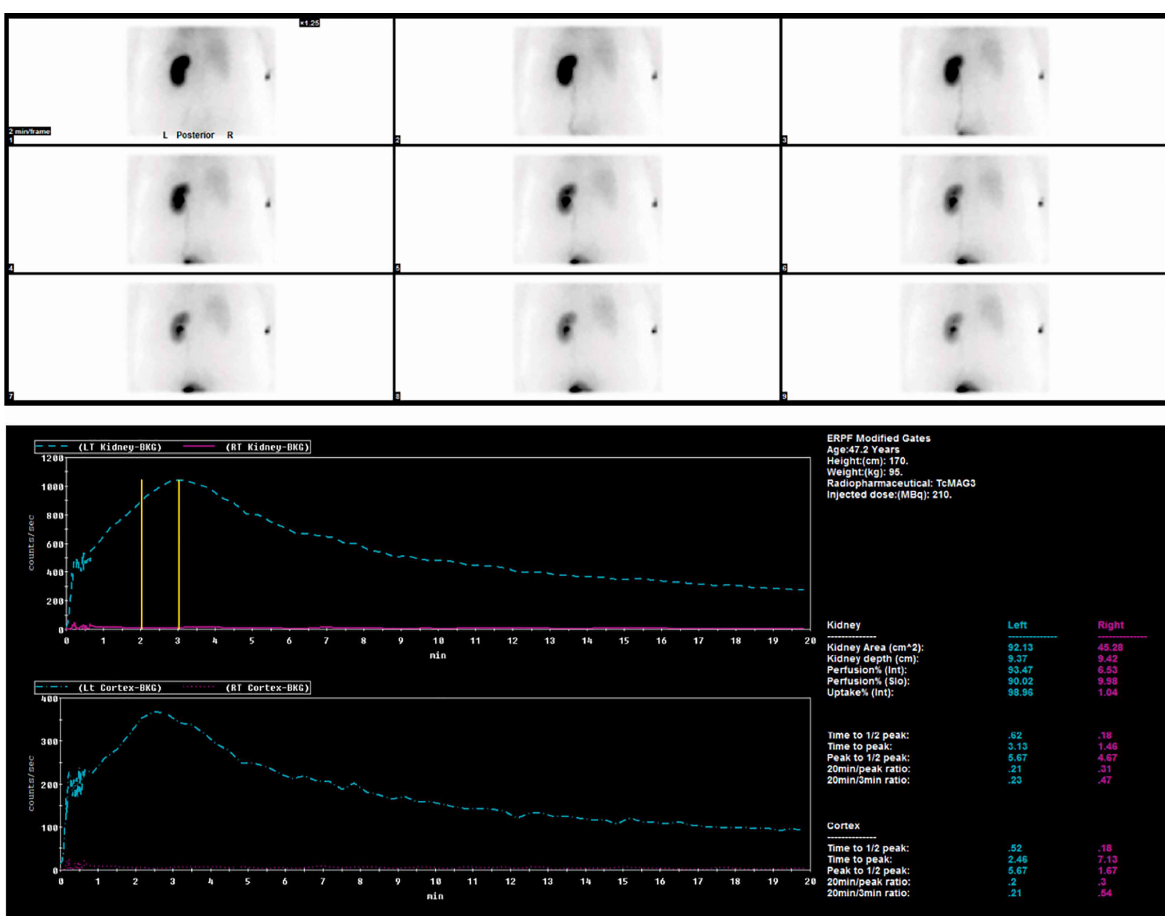
Figure 3: MAG3 scintigraphy showing complete loss of function of the right kidney.